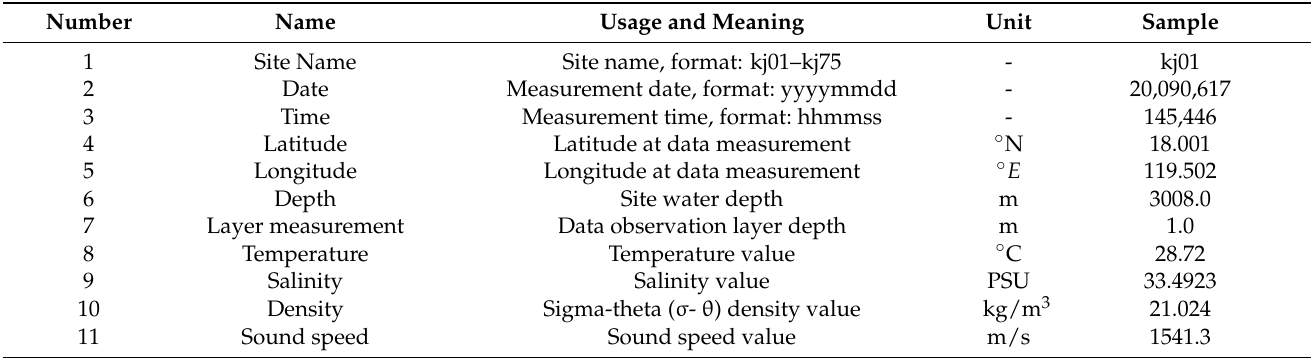
Table 1. Dataset content.